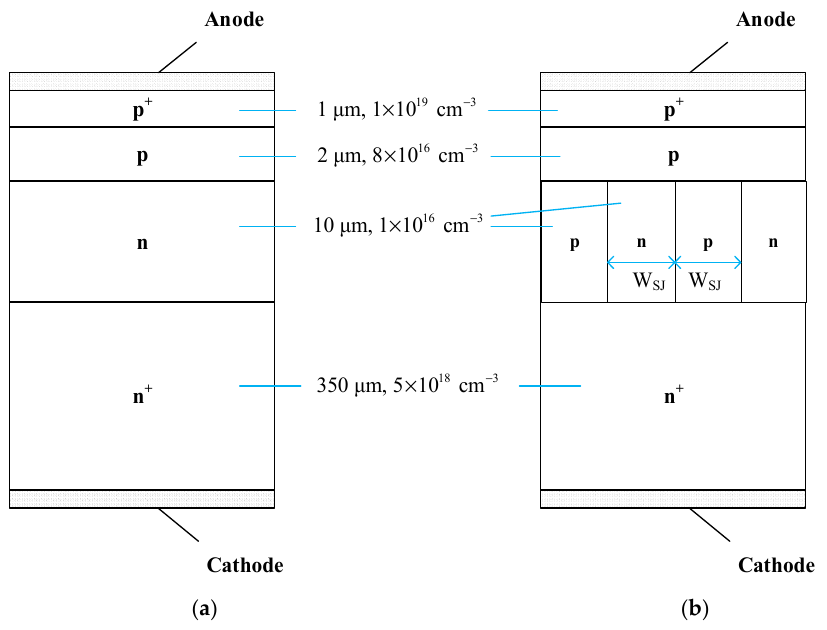
Figure 1. Profiles of ( a ) conventional SiC DSRD and ( b ) SJ SiC DSRD.